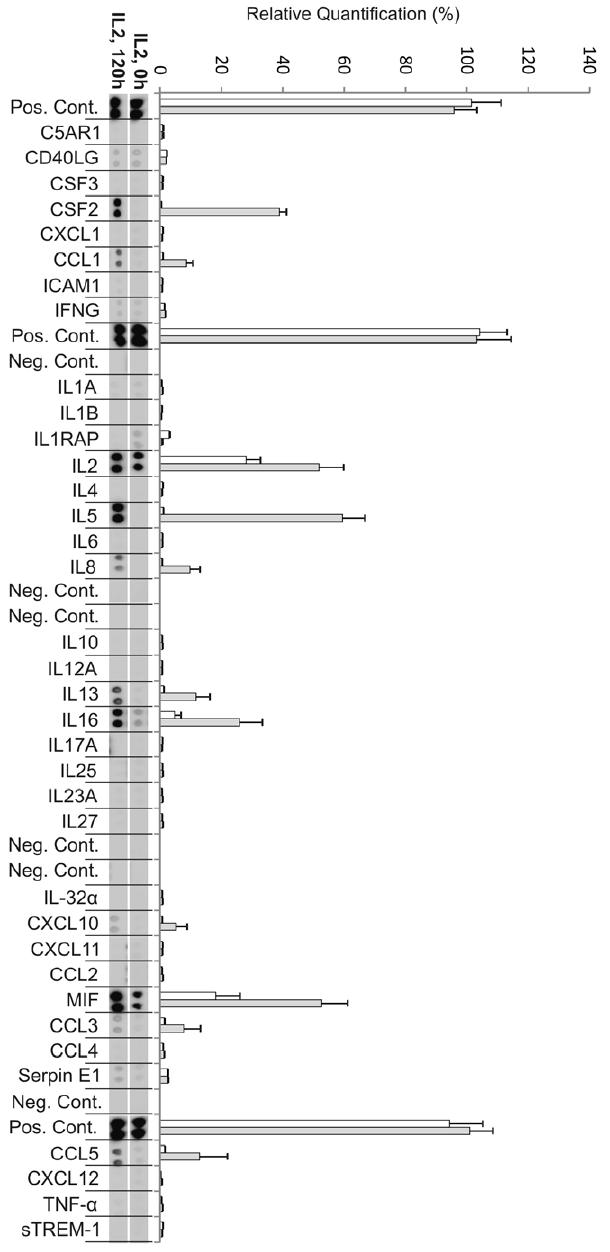
Figure 5. Cytokine production from IL-2 stimulated CD3 + T cells at day zero (0 h) and day five (120 h). Relative quantification of spot intensities was performed using Quantity One software (Bio- Rad). Each bar represents an average of the intensity from two protein spots. White bars represent 0 h and grey bars represent 120 h (day 5). Cytokines IL-5, MIF, and GM-CSF (CSF2) were present at a high level in the supernatant after five days.